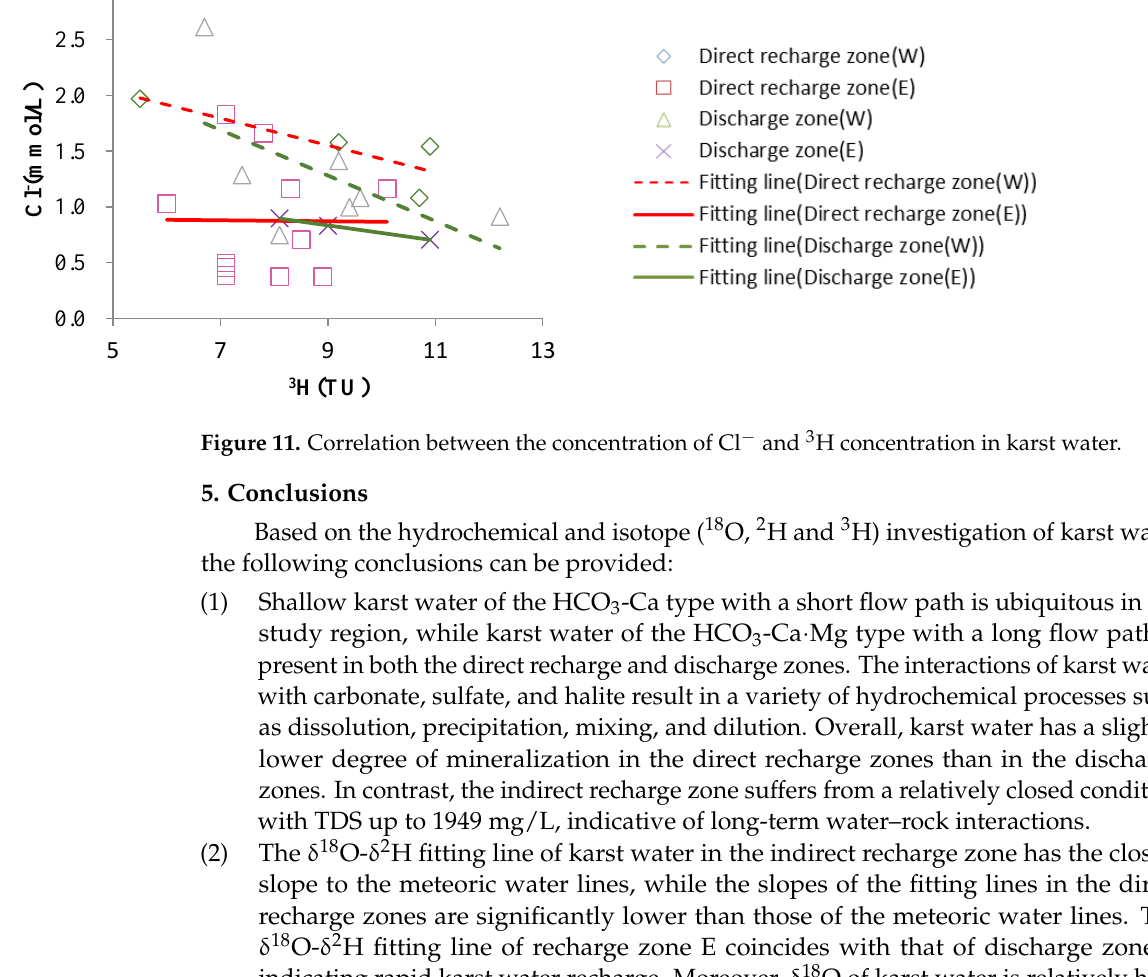
Figure 11. Correlation between the concentration of Cl − and 3 H concentration in karst water.